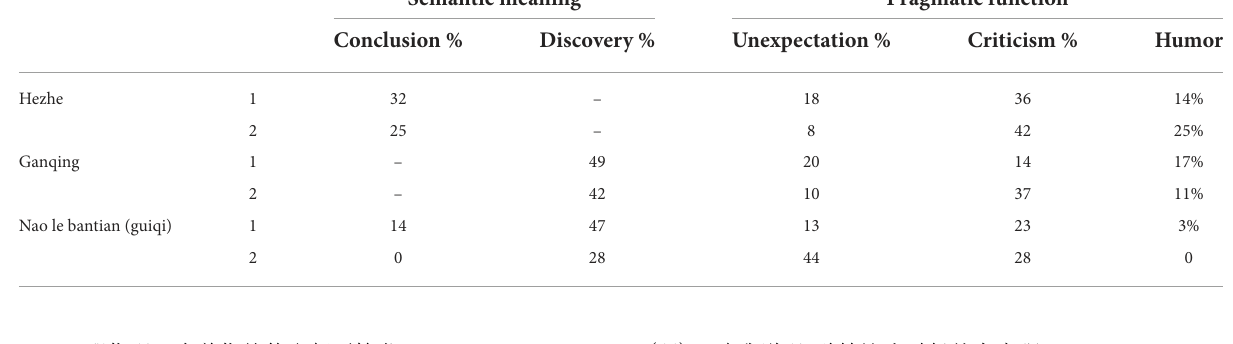
TABLE 2 Distribution of three adverbs in two